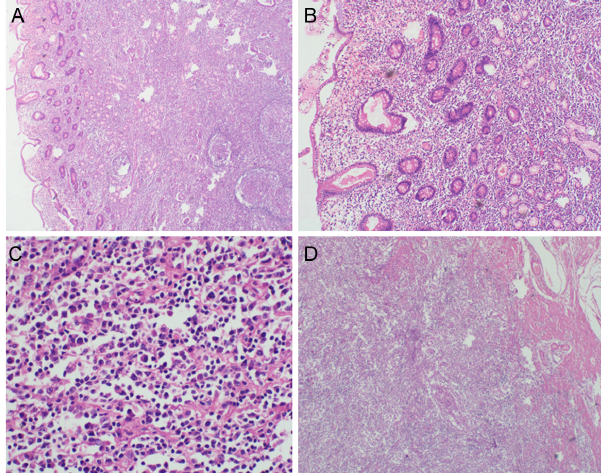
Figure 2. (A) Section from gastrectomy specimen from a case of primary gastric lymphoma showing overlying foveolar epithelium and transmural diffuse infiltration by atypical lymphoid cells, with formation of germinal centers (hematoxylin and eosin [H & E], × 4). (B) Section from gastrectomy specimen showing overlying foveolar epithelium and transmural diffuse infiltration by atypical lymphoid cells. (H & E, × 10). (C) The atypical lymphoid cells are disposed in sheets and are fairly monomorphic, small in size, display round to oval irregular, angulated nuclei, clumped chromatin, inconspicuous nucleoli, and scant cytoplasm (H & E, × 40). (D) The tumor can be seen to infiltrate the muscularis propria (H & E, ×